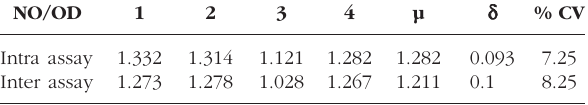
Table I. – Determination of intra and inter assay for showing the reproducibility of